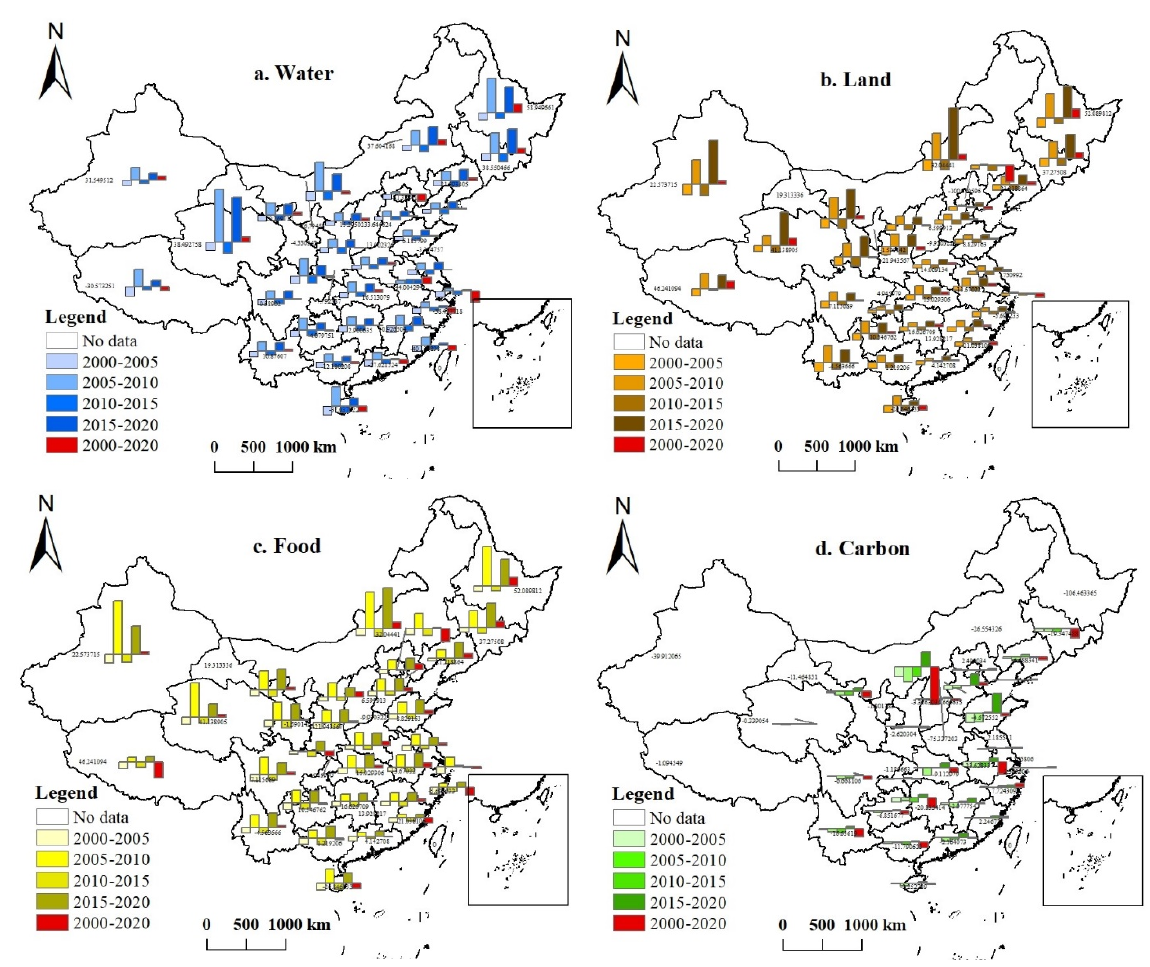
Figure 8. Evolution of spatial pattern of “Water–Land–Food–Carbon”.